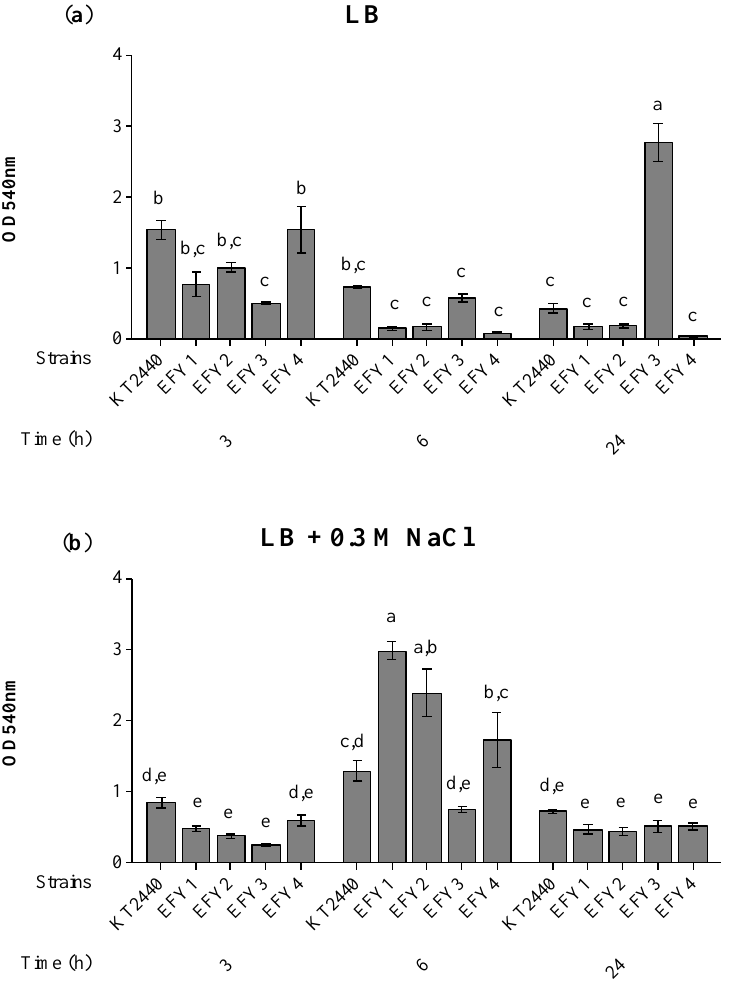
Figure 4. Bacterial adhesion to the surface of polystyrene microtiter plates of P. putida KT2440 and the isolates EFY1, EFY2, EFY3, and EFY4, grown in ( a ) LB and ( b ) LB + 0.3 M NaCl. Data are plotted as mean values ± standard error. Different letters indicate significant differences among the strains in the same media ( p < 0.05, Tukey’s test). Bacterial adherence to seeds is a key step for PGPB to be successful in plant growth